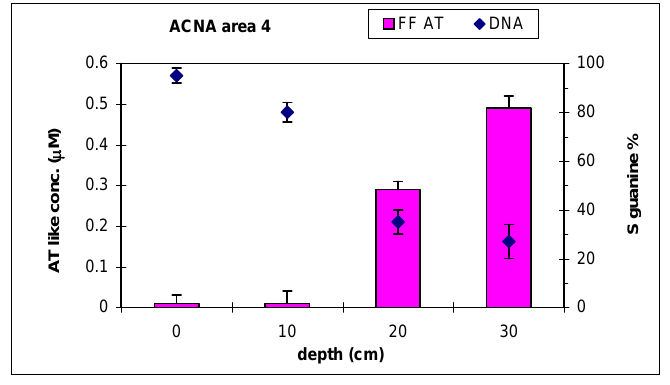
Figure 9. Excitation (a) and emission (b) spectra of 0.5 µM AT performed in 50 mM PBS pH 3.0.